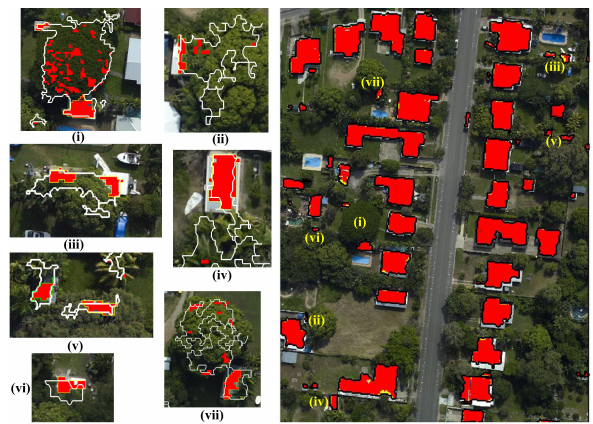
Figure 5. (a) Vegetation removal and recovery of occluded build- ings, (b) Detected buildings